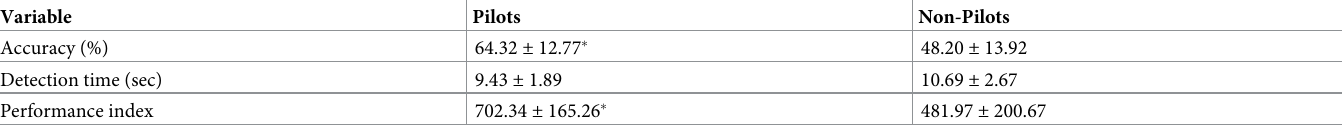
Table 1. Error-detection accuracy, detection time, and performance index for the cockpit task per group (mean ± SD).